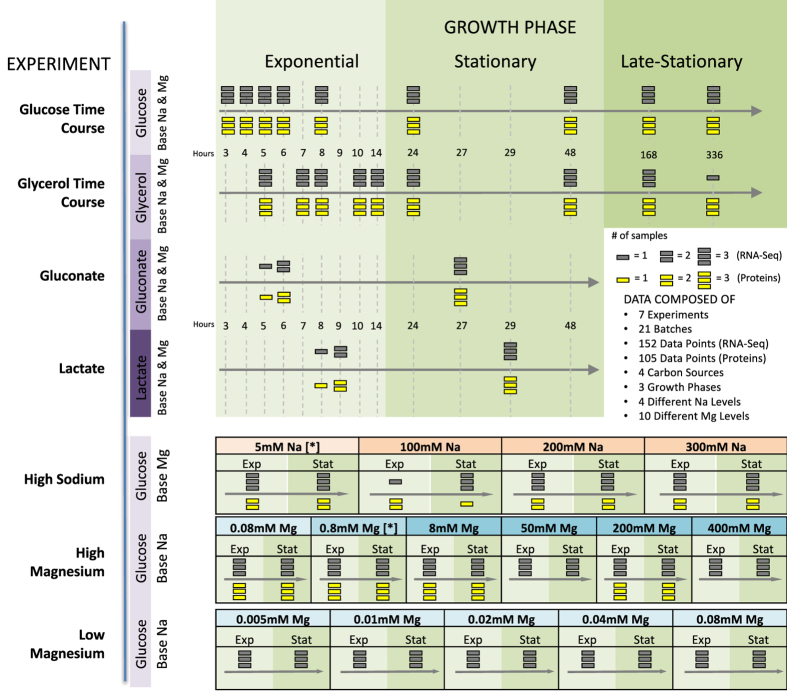
Experimental setup.We performed seven different experiments in which we varied the duration of growth and the temporal density of sampling, the carbon source, and ion concentrations. For each experimental condition, bacteria were grown in three biological replicates. Conditions that are listed multiple times represent independent replicates of those conditions. We subsequently performed whole-transcriptome RNA-Seq for all experimental conditions and mass-spec proteomics for the majority of them. (No proteomics was performed for the low-magnesium experiment.) We considered four different carbon sources: glucose, glycerol, gluconate, and lactate; we also considered high sodium and both low and high magnesium levels. For the time-course and carbon-source experiments, we used base-level Na+ (5 mM) and Mg2+ (0.8 mM) throughout (indicated by [*] in the sodium and magnesium experiments).